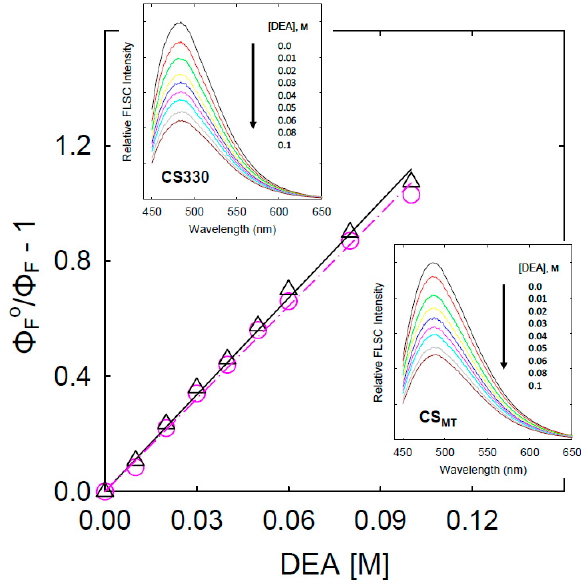
Figure 5. Stern–Volmer plots for the quenching of fluorescence emission intensity by DEA for CS330 (triangle, solid line) and CS MT (circle, dash ‐ dot line) in ethanol solutions, with the slopes (Stern– Volmer constants) of 11.2 M ‐ 1 and 10.7 M ‐ 1, respectively. Insets: The corresponding fluorescence emission spectra with the quenching at different DEA concentrations.